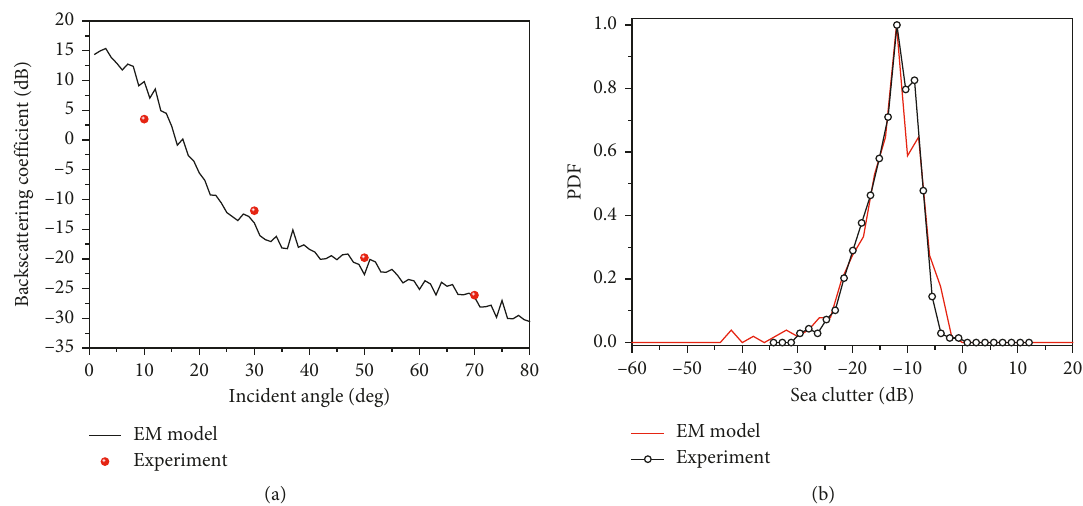
Figure 1: Validations on the performance of the FBAM. (a) Backscattering coefficient. (b) PDF of the time series of sea clutter.